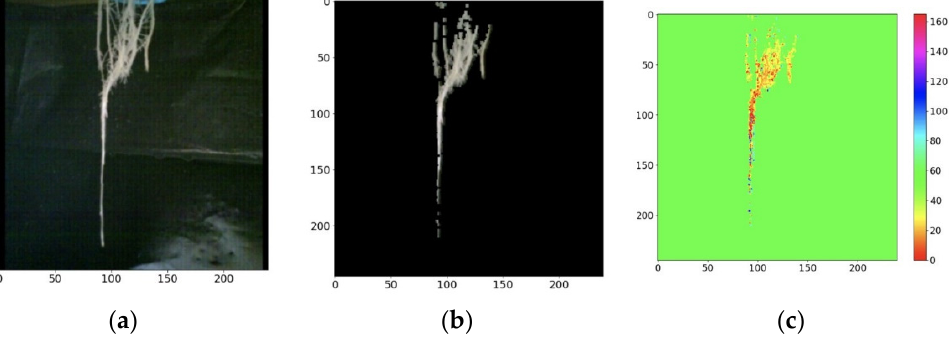
Figure 14. RGB and HSV images enhanced at root (day 1). ( a ) Original image of the root; ( b ) enhanced RGB image; ( c ) enhanced HSV image.